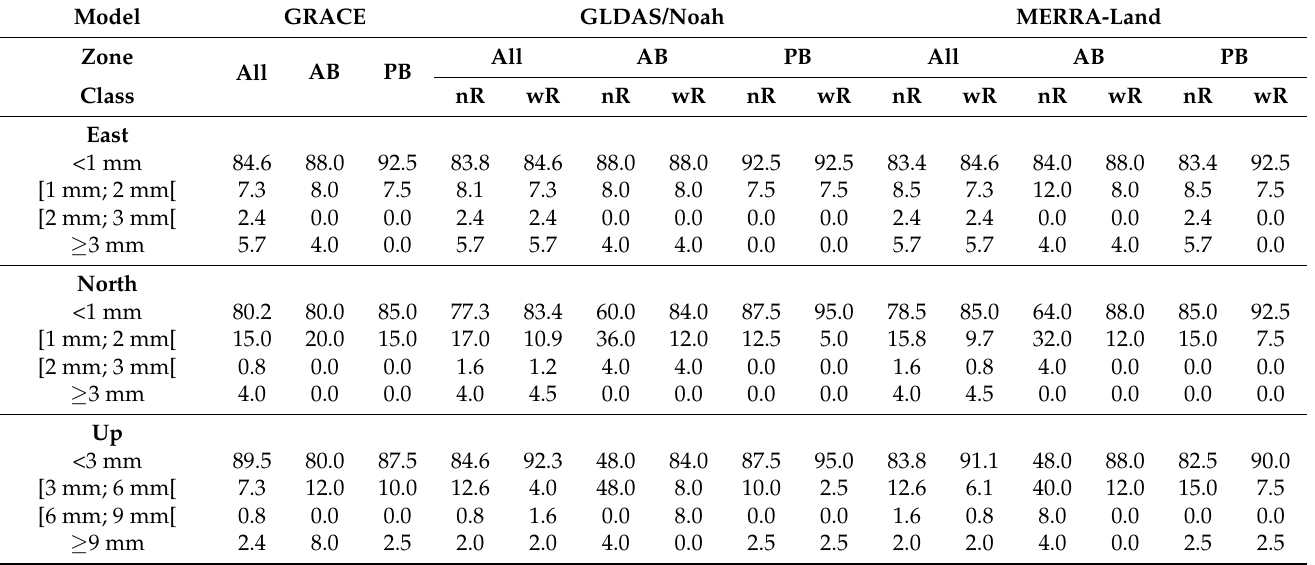
Table 3. Distribution of the CRMS (in %) for the different models for different subsets of stations: all the sta- tions (247), Amazon basin (25 stations), and Parana (40 stations), designated by the acronyms “All”, “AB”, “PB”, respectively. The models without the rivers are provided in the “nR” columns, the ones including the river are in the “wR” columns. The horizontal and vertical classes are different to take into account the relative difference in terms of accuracy and signal amplitude. Model Zone